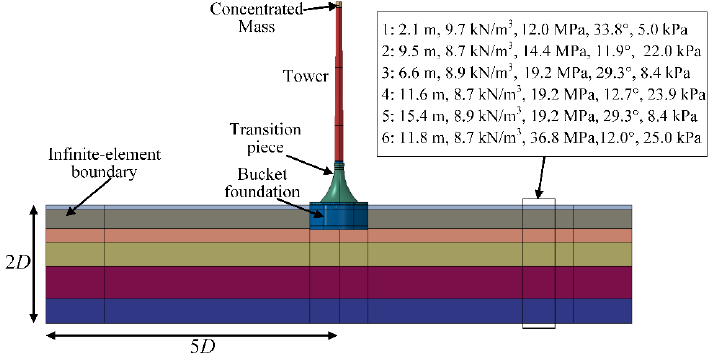
Figure 12. The half of the FEM model used in this study.